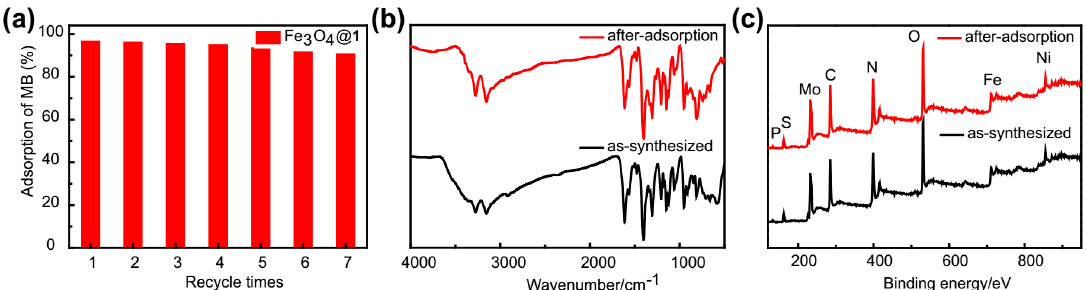
Figure 11. ( a ) The reusability studies of Fe 3 O 4 @ 1 . The after-adsorption and as-synthesized ( b ) FTIR and ( c ) XPS spectra of Fe 3 O 4 @ 1 .